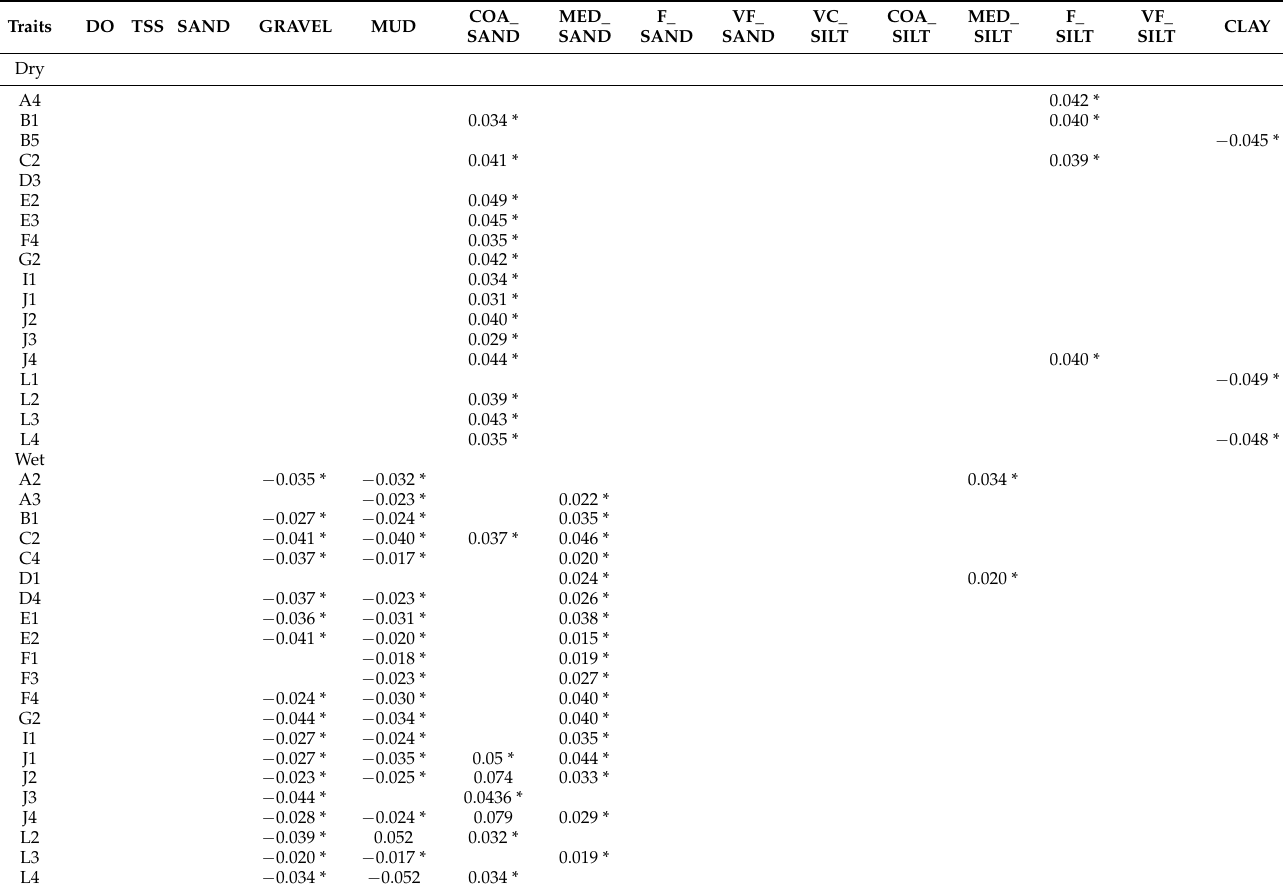
Table 4. Fourth-corner statistics after 4999 permutations showing correlation coefficient and level of probability of statistical significance for correlation between traits and environmental variables during the dry and wet seasons. * ( p ≤ 0.05). Only significant correlations are